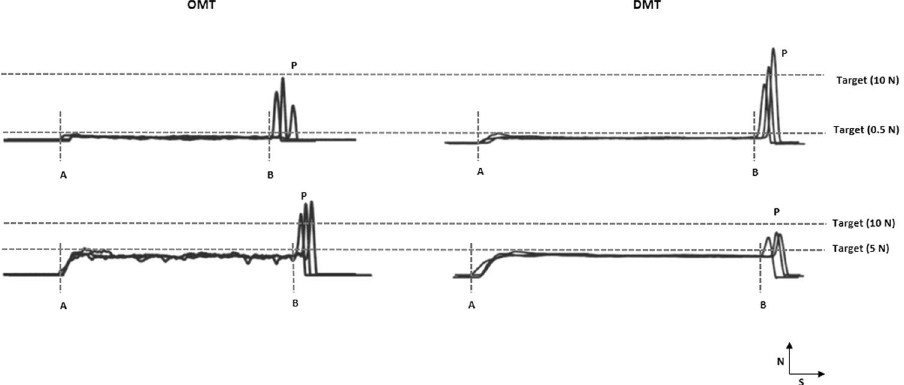
Figure 2. The typical force profiles obtained by superimposition of three trials of the task during the four experimental sessions. X-axis represents the time (S) and Y-axis represents force (N). Controlled force is the average force between the times intervals from the initial contact of the teeth/digits with the force transducer ( A ) until onset of the ballistic force ( B ). Ballistic force (P) is the maximum force prior to the moment after which the decline in force indicated by a rapid ramp decrease in the force